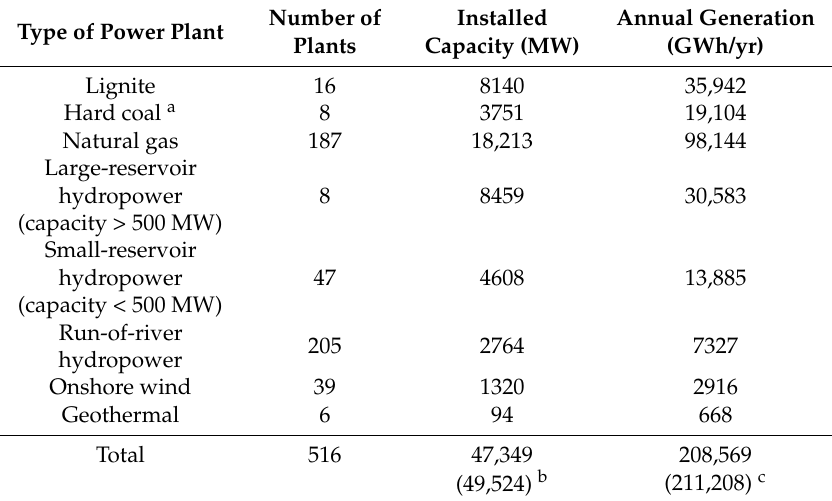
Table 2. Power plants in Turkey (2010).